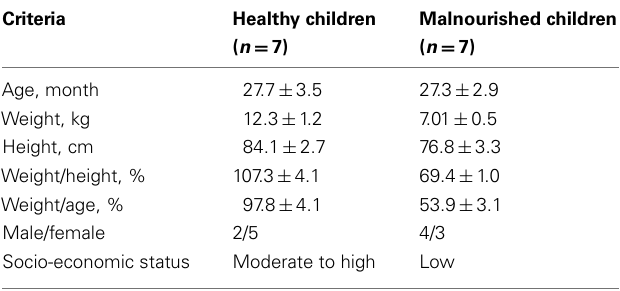
Table 1 | Baseline characteristics of study